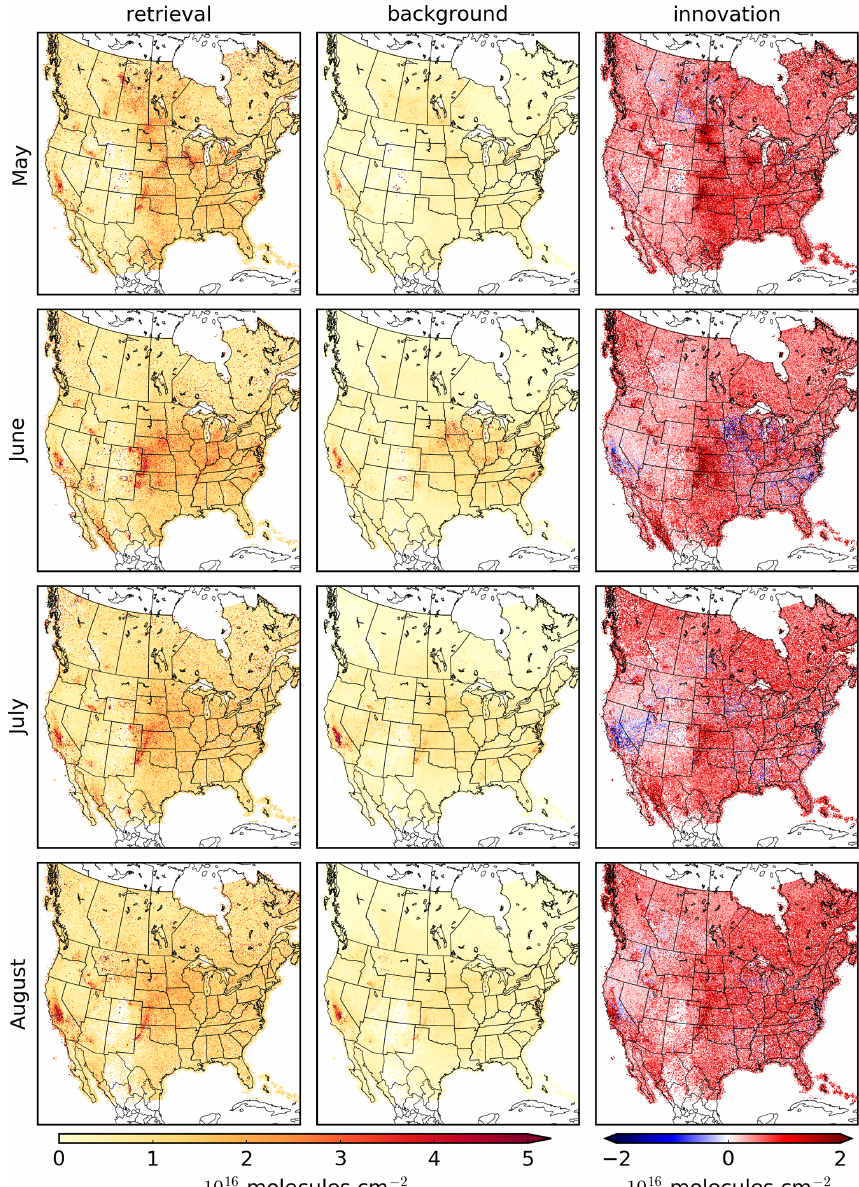
Figure 4. Monthly mean ammonia total columns for the CrIS retrievals (left column) compared to the analogous quantities for GEM-MACH run using the original set of emissions (the background, middle column), as well as their difference (innovation, right column), for May to August 2016. The GEM-MACH columns are calculated using the hybrid method given in Eq. (8). The values plotted are monthly means binned on the GEM-MACH grid. For plots of the innovation, each difference i within a cell is weighted by h i B cc h T the computation of the mean for that